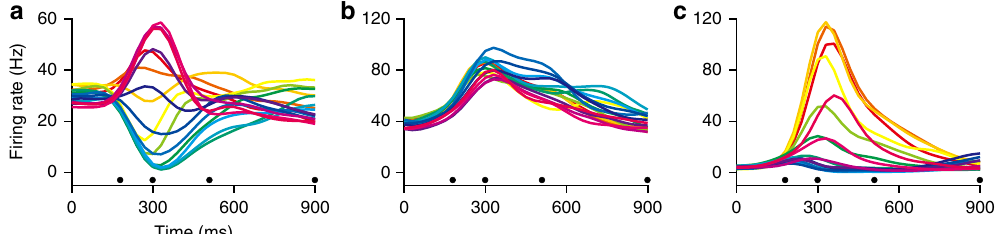
Fig. 3 Average fi ring rates of three representative units. Each trace corresponds to a target direction (same colormap as Fig. 1). a An example unit (Monkey N, 89-1) with a relatively small offset ratio ( − 0.082). b A unit (Monkey N, 32-2) with a large offset ratio of 0.868. c A unit (Monkey N, 55-1) with an intermediate offset ratio of 0.370